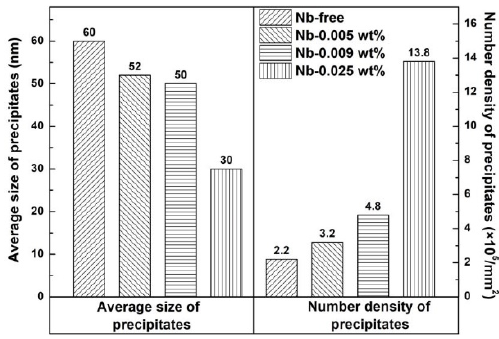
Figure 3. Size and number density of precipitates in hot-rolled bands.